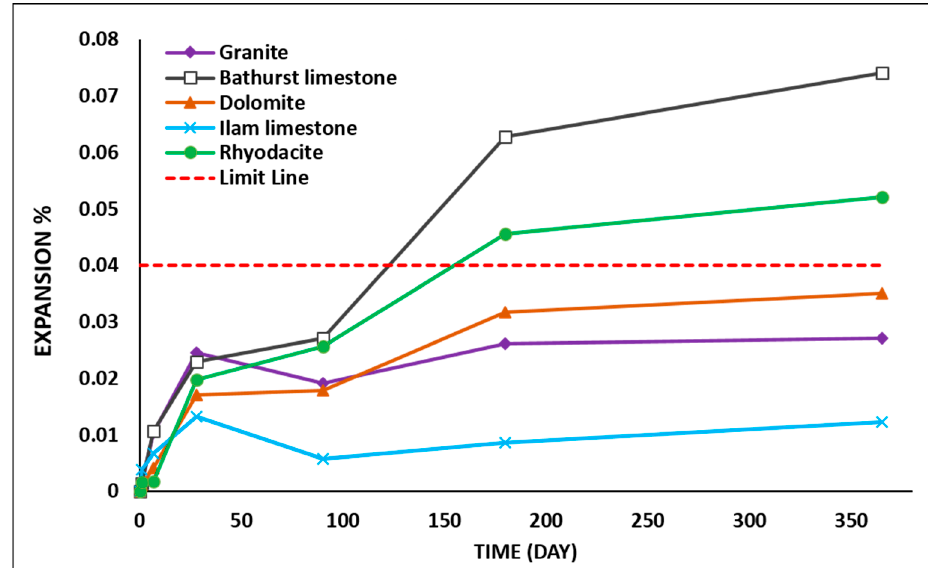
Figure 9. Concrete prism test results (ASTM C 1293).